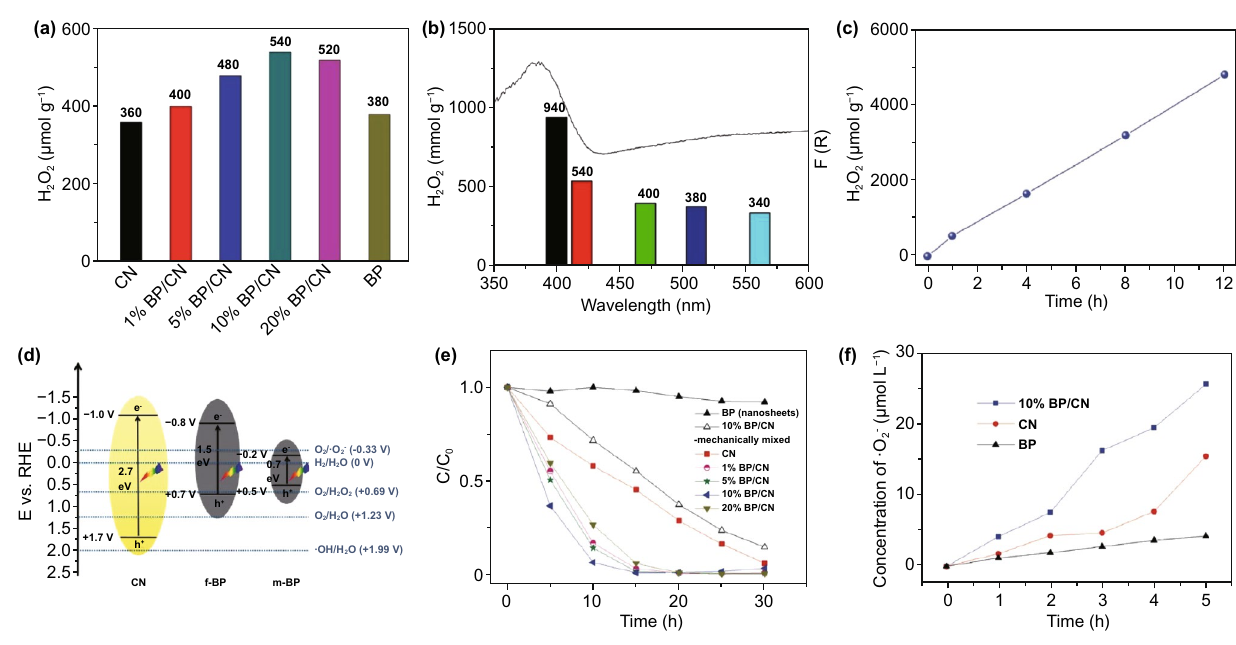
Fig. 7 Layered heterostructure structured black phosphorous/graphitic carbon nitride (BP/CN) nanomaterials for efficient photocatalysis. Repro- duced with permission [334]. Copyright 2018, rGO) exhibited a 86% and 98% reduction in ibuprofen by photocatalytic degradation under optical light and solar light irradiation, respectively [335].